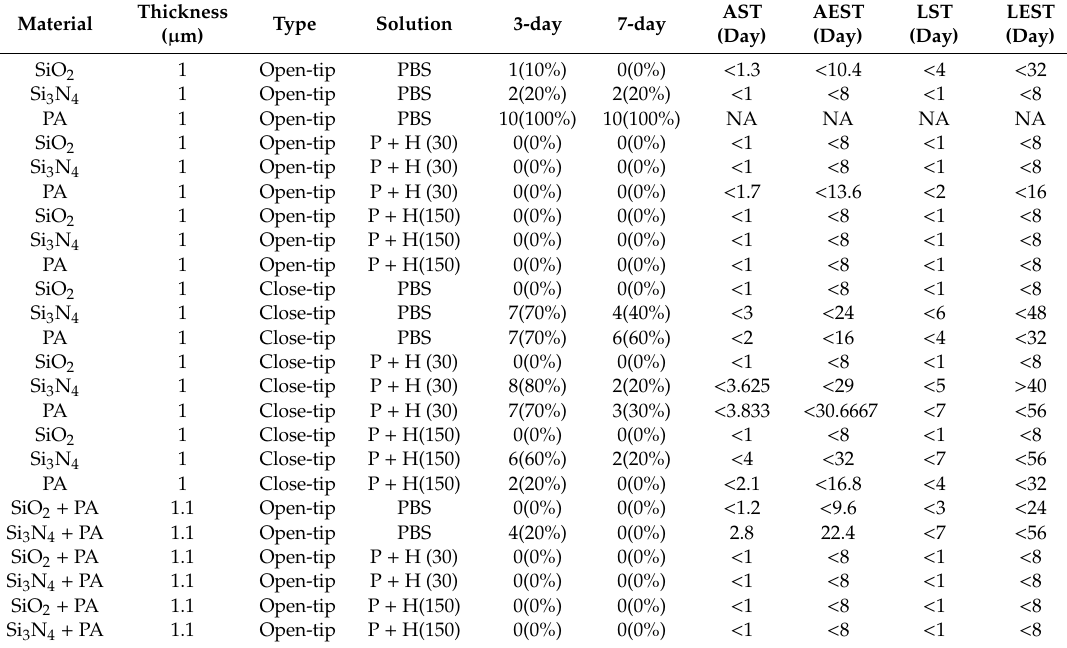
Table 3. Survival probabilities of all non-organic coating and composite design samples.